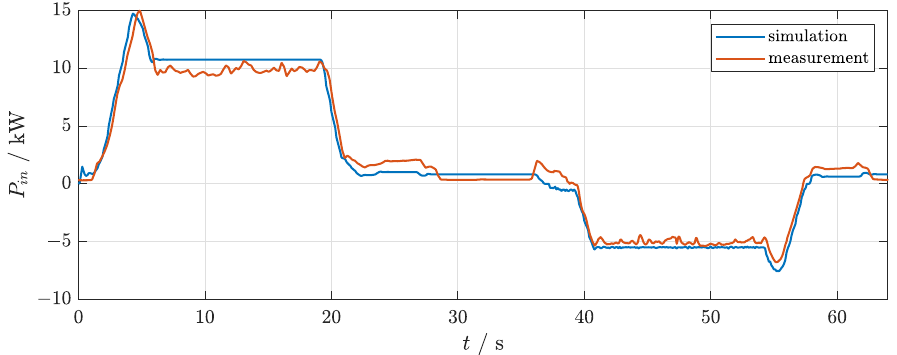
Figure 6. Comparison of power of the elevator system obtained from simulation and